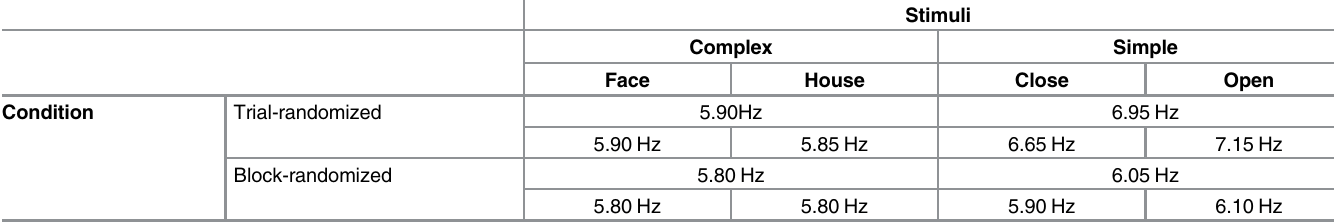
Table 1. Peak frequency of two randomization conditions with different